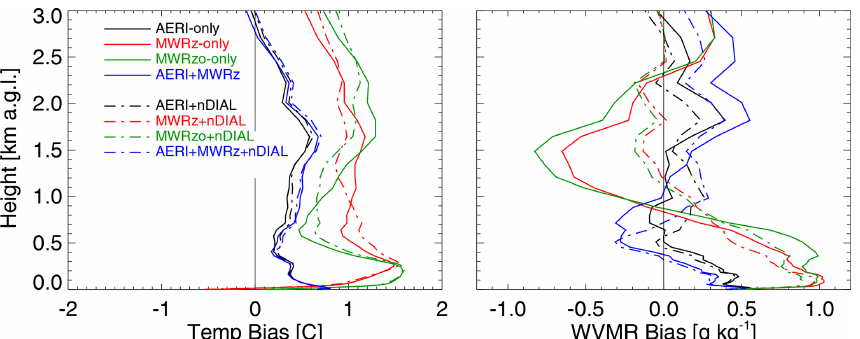
Figure 4. The bias in temperature (left) and water vapor mixing ratio (right) for passive-only (solid lines) and active + passive (broken lines) retrievals relative to radiosondes during Perdigão.